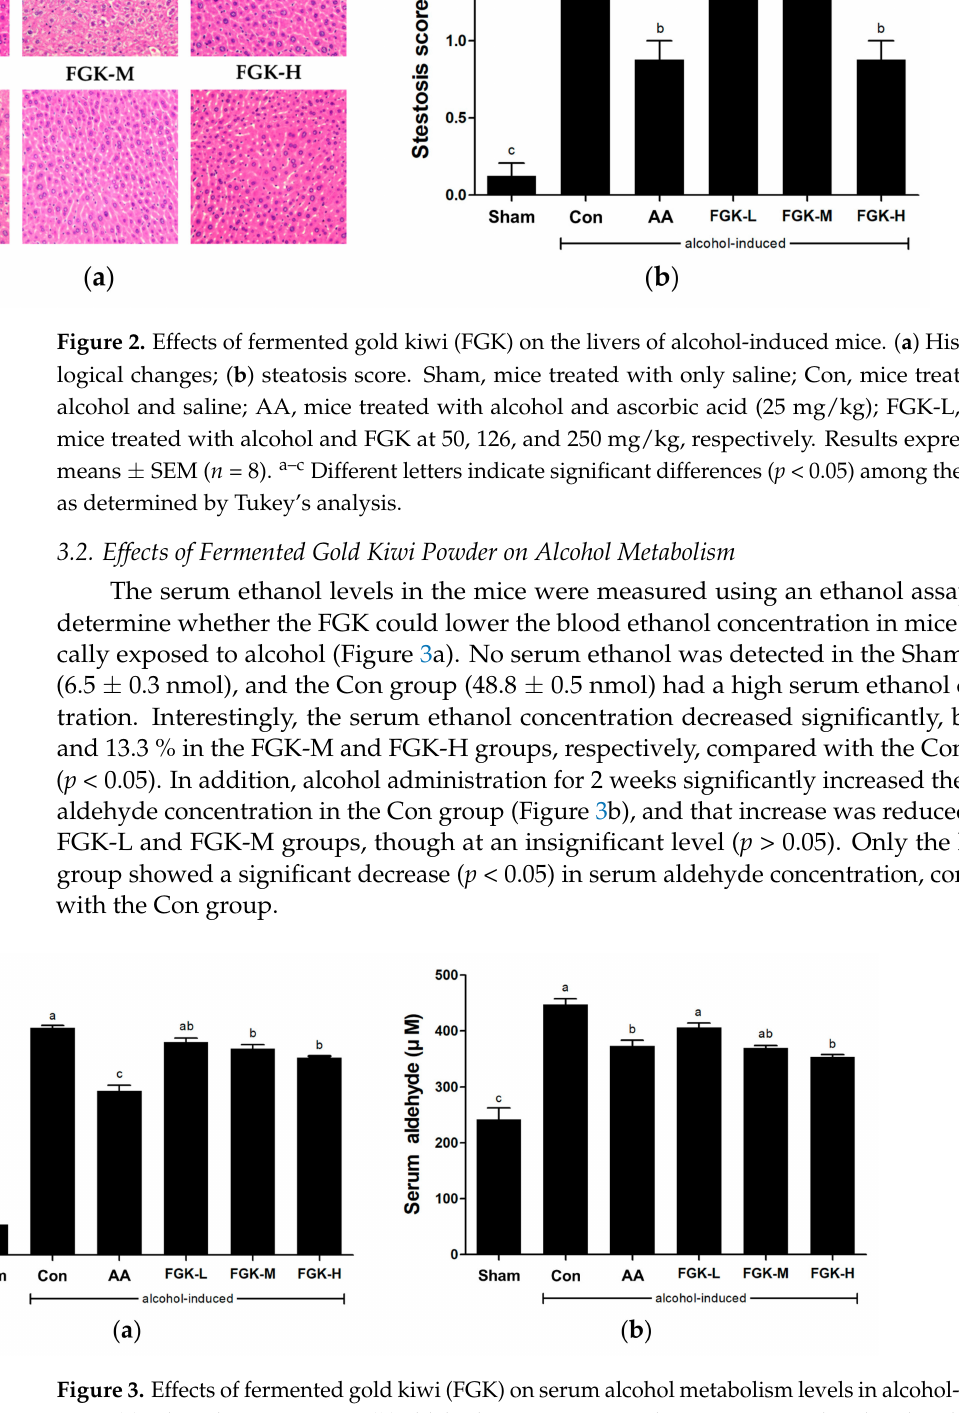
Figure 3. Effects of fermented gold kiwi (FGK) on serum alcohol metabolism levels in alcohol-induced mice. ( a ) Ethanol concentration; ( b ) aldehyde concentration. Sham, mice treated with only saline; Con, mice treated with alcohol and saline; AA, mice treated with alcohol and ascorbic acid (25 mg/kg); FGK-L, -M, -H, mice treated with alcohol and FGK at 50, 126, and 250 mg/kg, respectively. Results expression as means ± SEM ( n = 8). a–d Different letters indicate significant differences ( p < 0.05) among the groups, as determined by Tukey’s